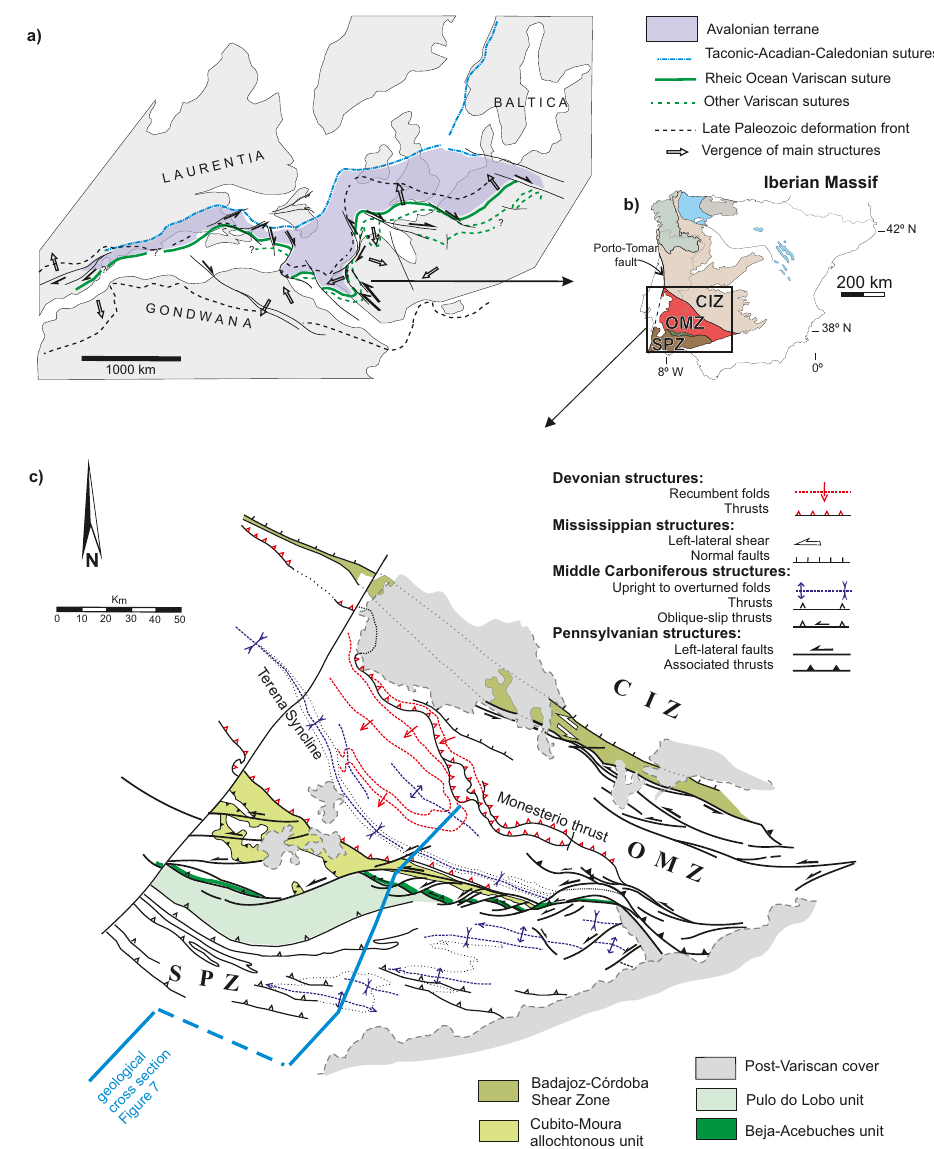
Figure 1. (a) Reconstruction of the Variscan-Alleghanian orogen at the end of the Carboniferous simplified from Simancas et al. (2005). The Avalonian continental piece and the inferred Rheic Ocean and other second-order Variscan sutures are depicted. The SW Iberian left-lateral shear sutures are highlighted. (b) Geological subdivision of the Iberian Massif. CIZ: Central Iberian Zone; OMZ: Ossa-Morena Zone; SPZ: South Portuguese Zone. (c) Structural map of the SW Iberia showing the main units and the different Devonian and Carboniferous structures. The location of the cross section in Fig. 7 is